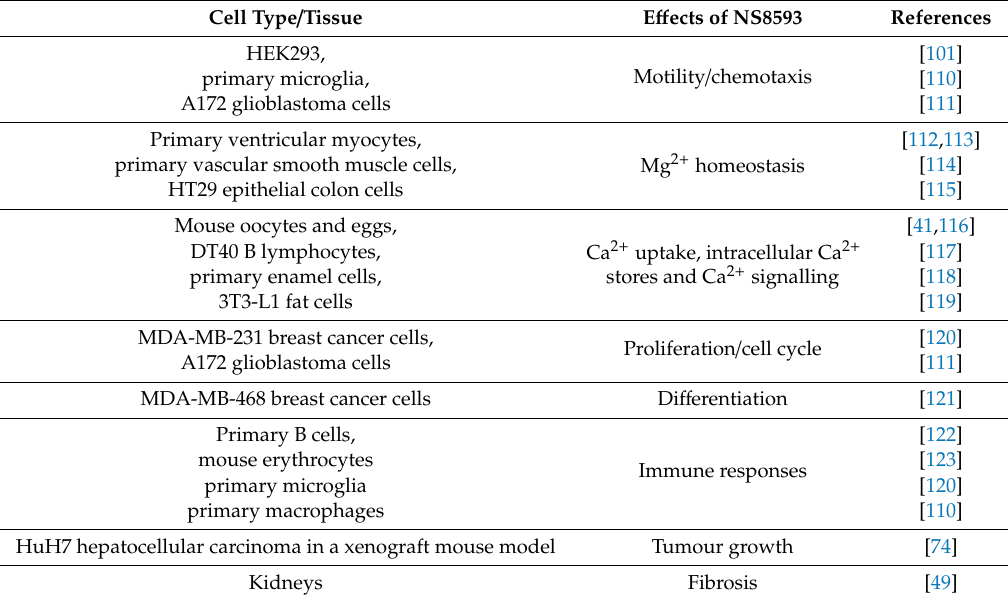
Table 1. Cellular processes a ff ected by